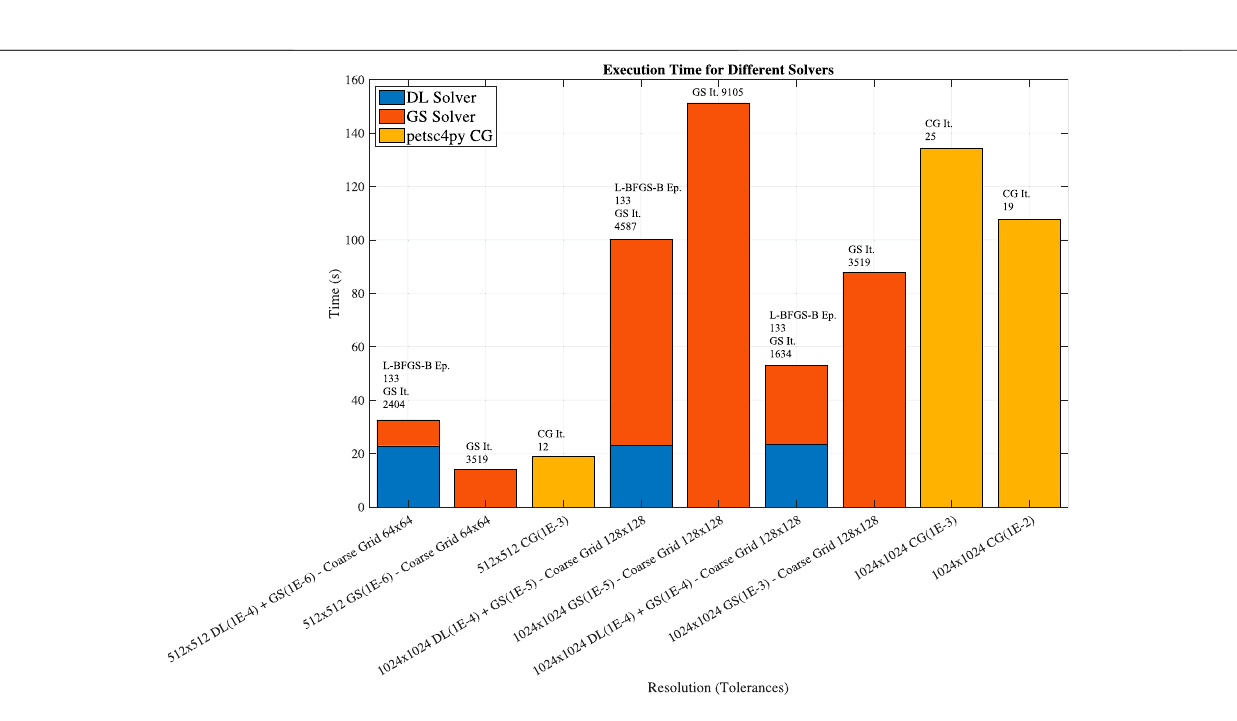
FIGURE10| Execution time, number ofepochsand iterations forthehybrid multigrid DL-GS solver and comparison withthe performanceofamultigridusing only GS and petsc4py CG varying the resolution, and solver stopping criteria. The hybrid multigrid DL-GS solver is faster for problems using larger coarse grids, e.g. 128 × 128 coarse grids, than the other